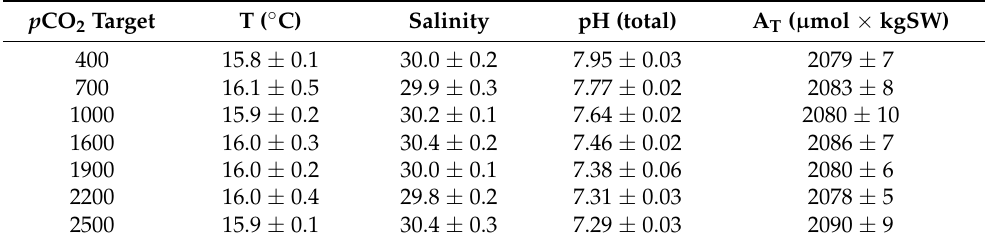
Table 1. Measured seawater carbonate parameters during OA treatments and their respective variability ( ± 1 SD). Measurement uncertainties for each parameter were as follows: temperature